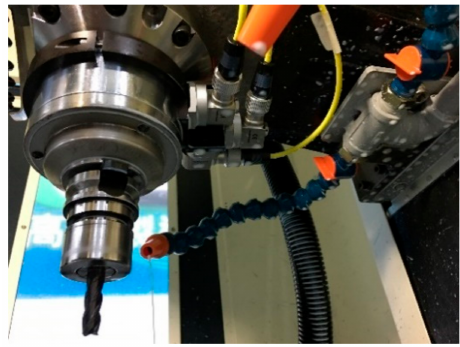
Figure 1. Installation locations of accelerometers at the spindle.